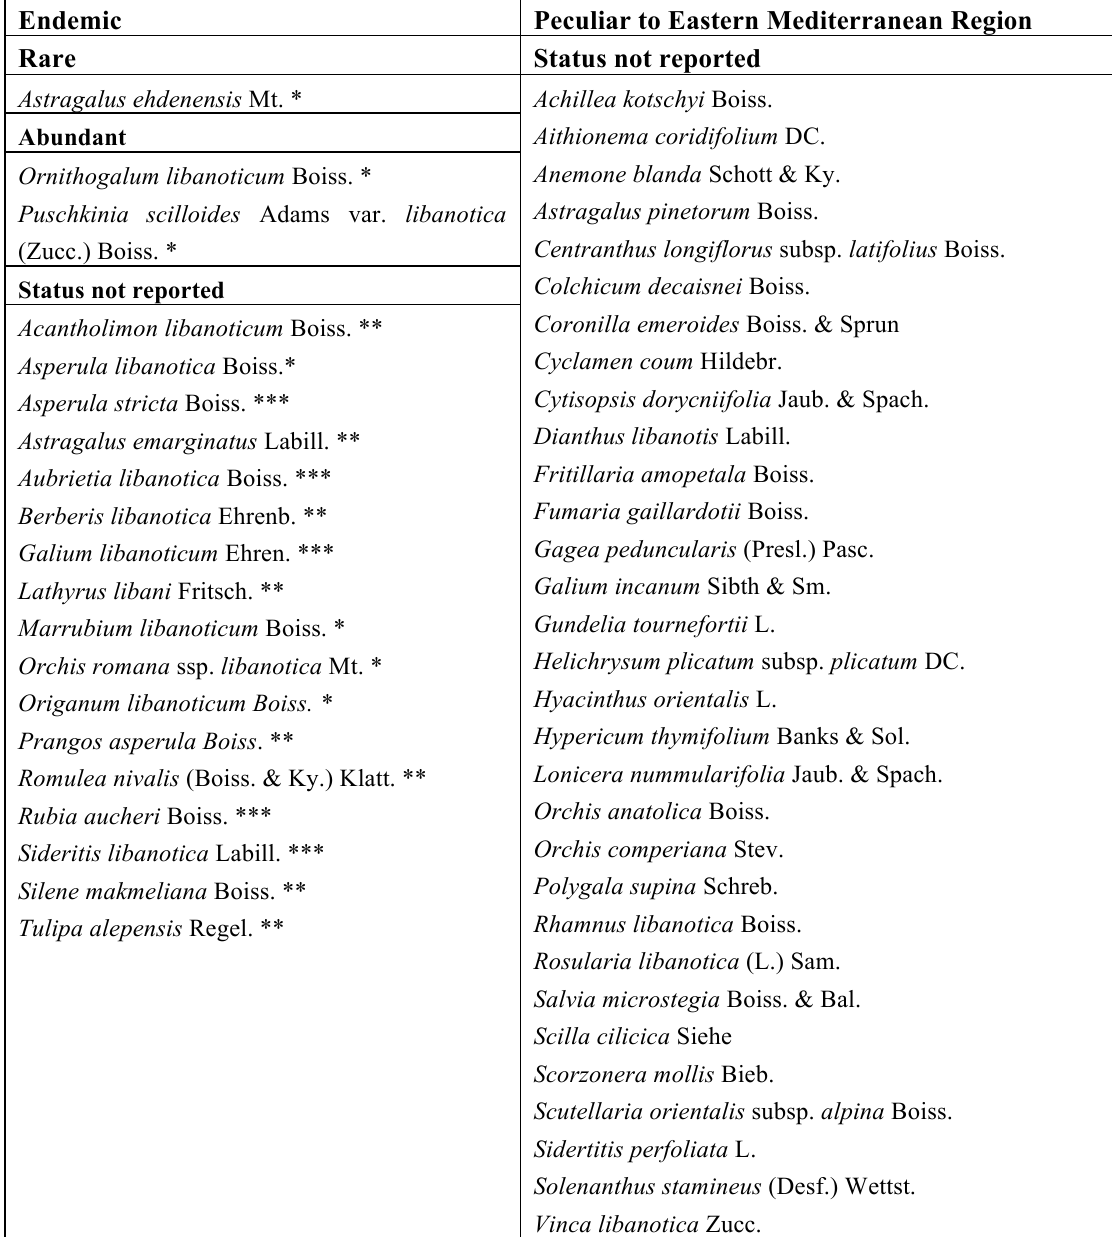
Table 4. Ecological status and specificity of some of the herbaceous, bulbous and bush species collected in the four study